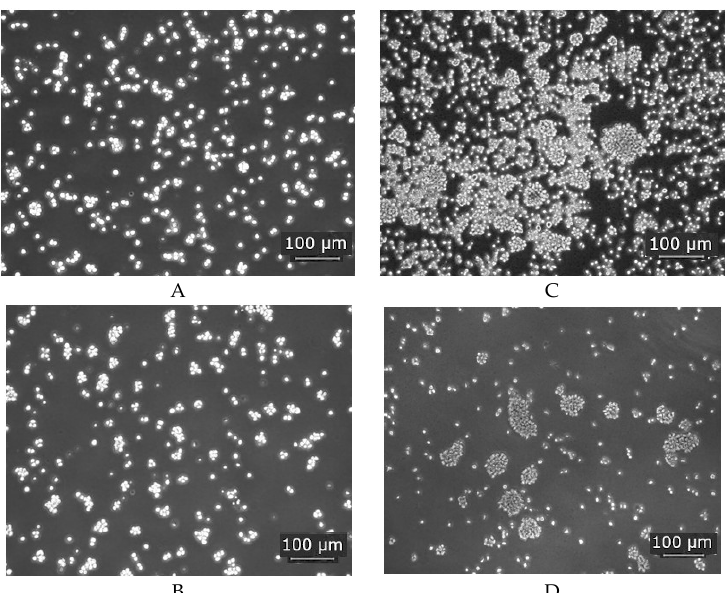
Figure 3. Imaging of THP1-monocytes cultures. Cells were cultured in RPMI medium with 10% FBS -control condition for 24 h ( A ) and control condition for 48 h ( B ); THP1-monocytes cultured in RPMI medium with 10% Fetal Bovine Serum (FBS) with Biodentine TM for 24 h ( C ) and for 48 h ( D ). Normal cells are visible. Experiments were conducted as six separate assays (each assay in three